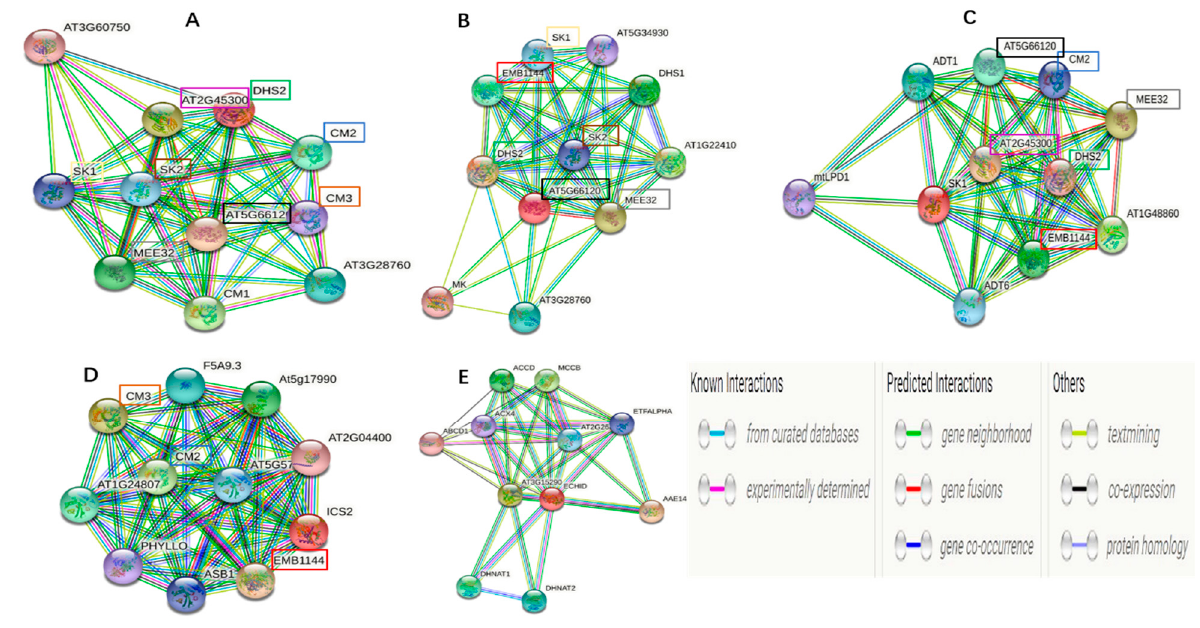
Figure 10. Protein interaction network predictions of DAHPS ( A ), DHQS ( B ), SKM ( C ), ICS ( D ), and MenB ( E ) based on orthologs in Arabidopsis thaliana . The network was predicted by STRING (Version 11.5, http://string-db.org (accessed on 5 December 2020)).